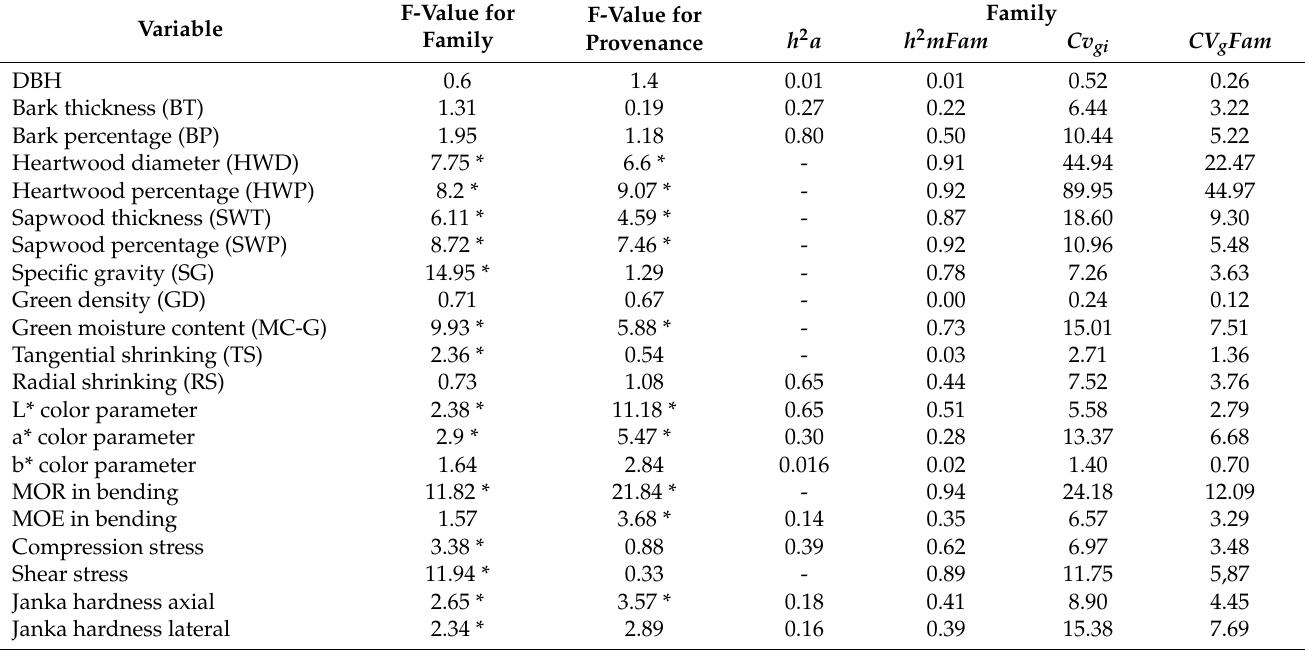
Table 4. Genetic parameters of Dipteryx panamensis wood properties in native provenances and families from Costa